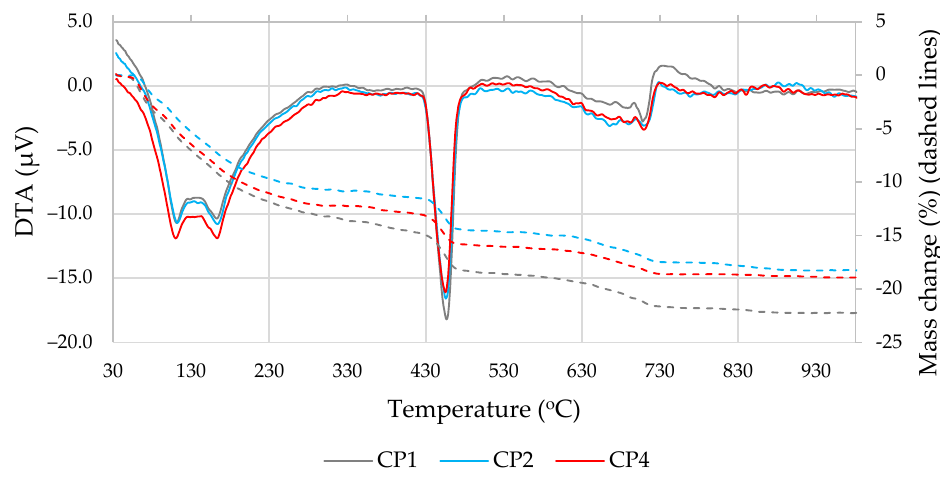
Figure 9. DTA and TG results after 7 days of curing.